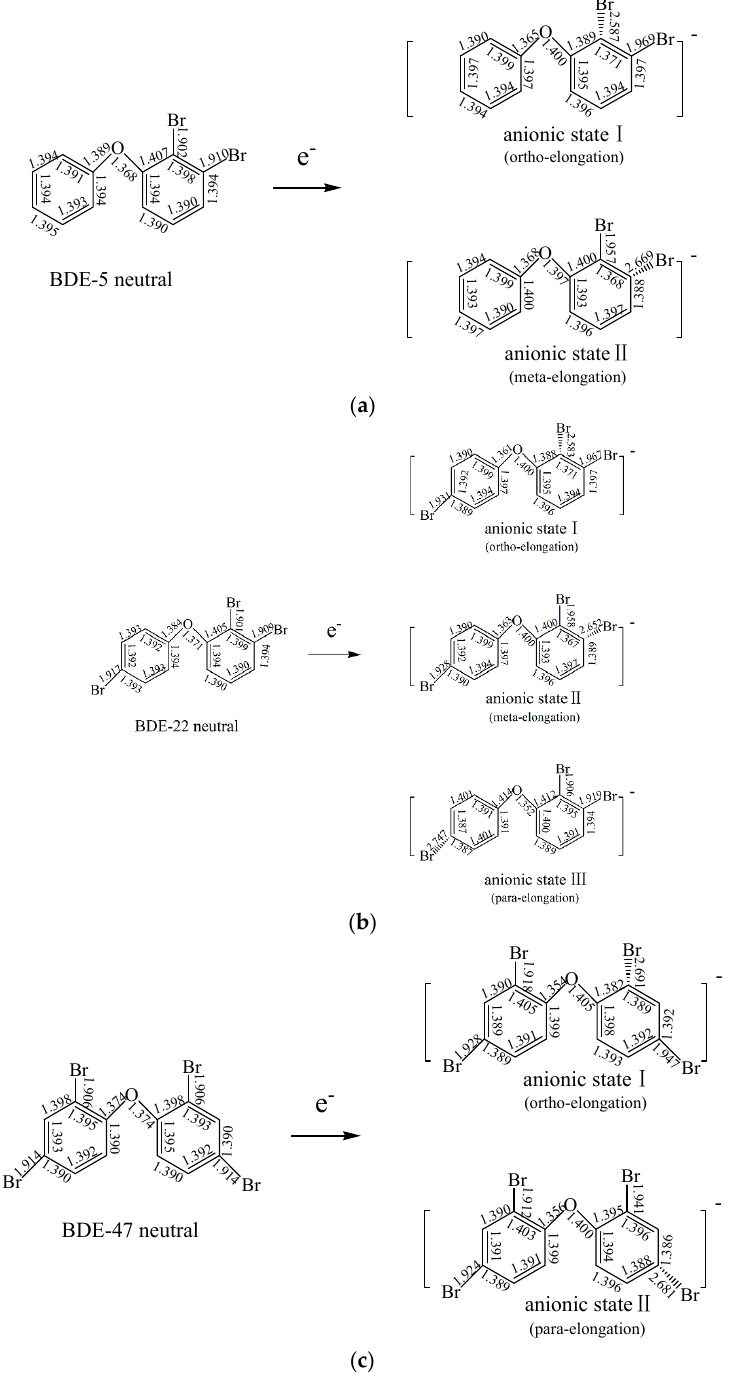
Figure 3. ( a ) Optimized geometries of BDE-5 and its possible anionic states; ( b ) Optimized geometries of BDE-22 and its possible anionic states; ( c ) Optimized geometries of BDE-47 and its possible anionic states.